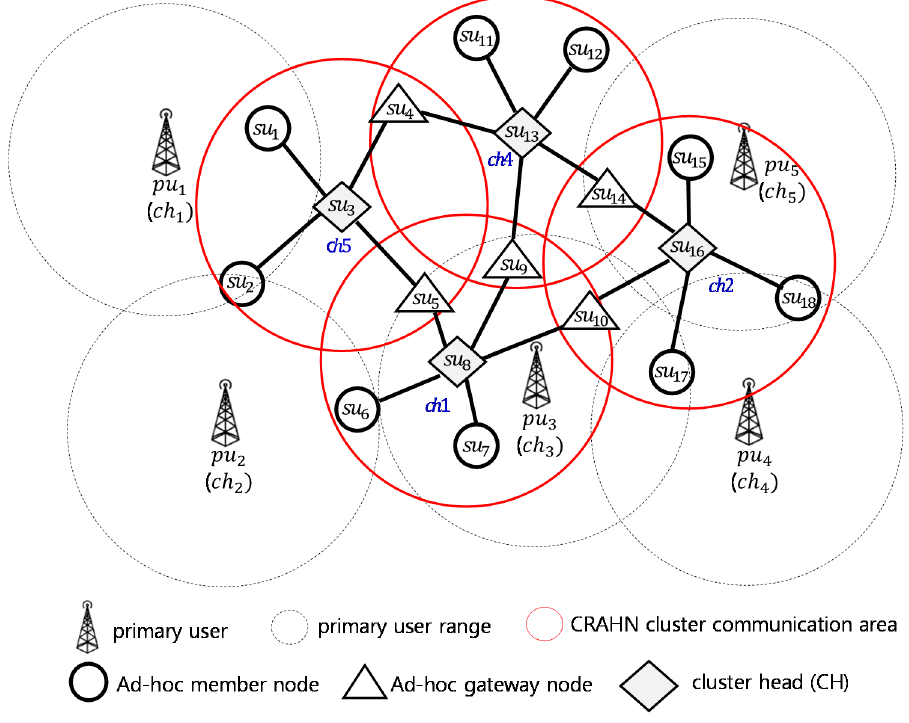
Figure 2. CRAHN coexistence model.